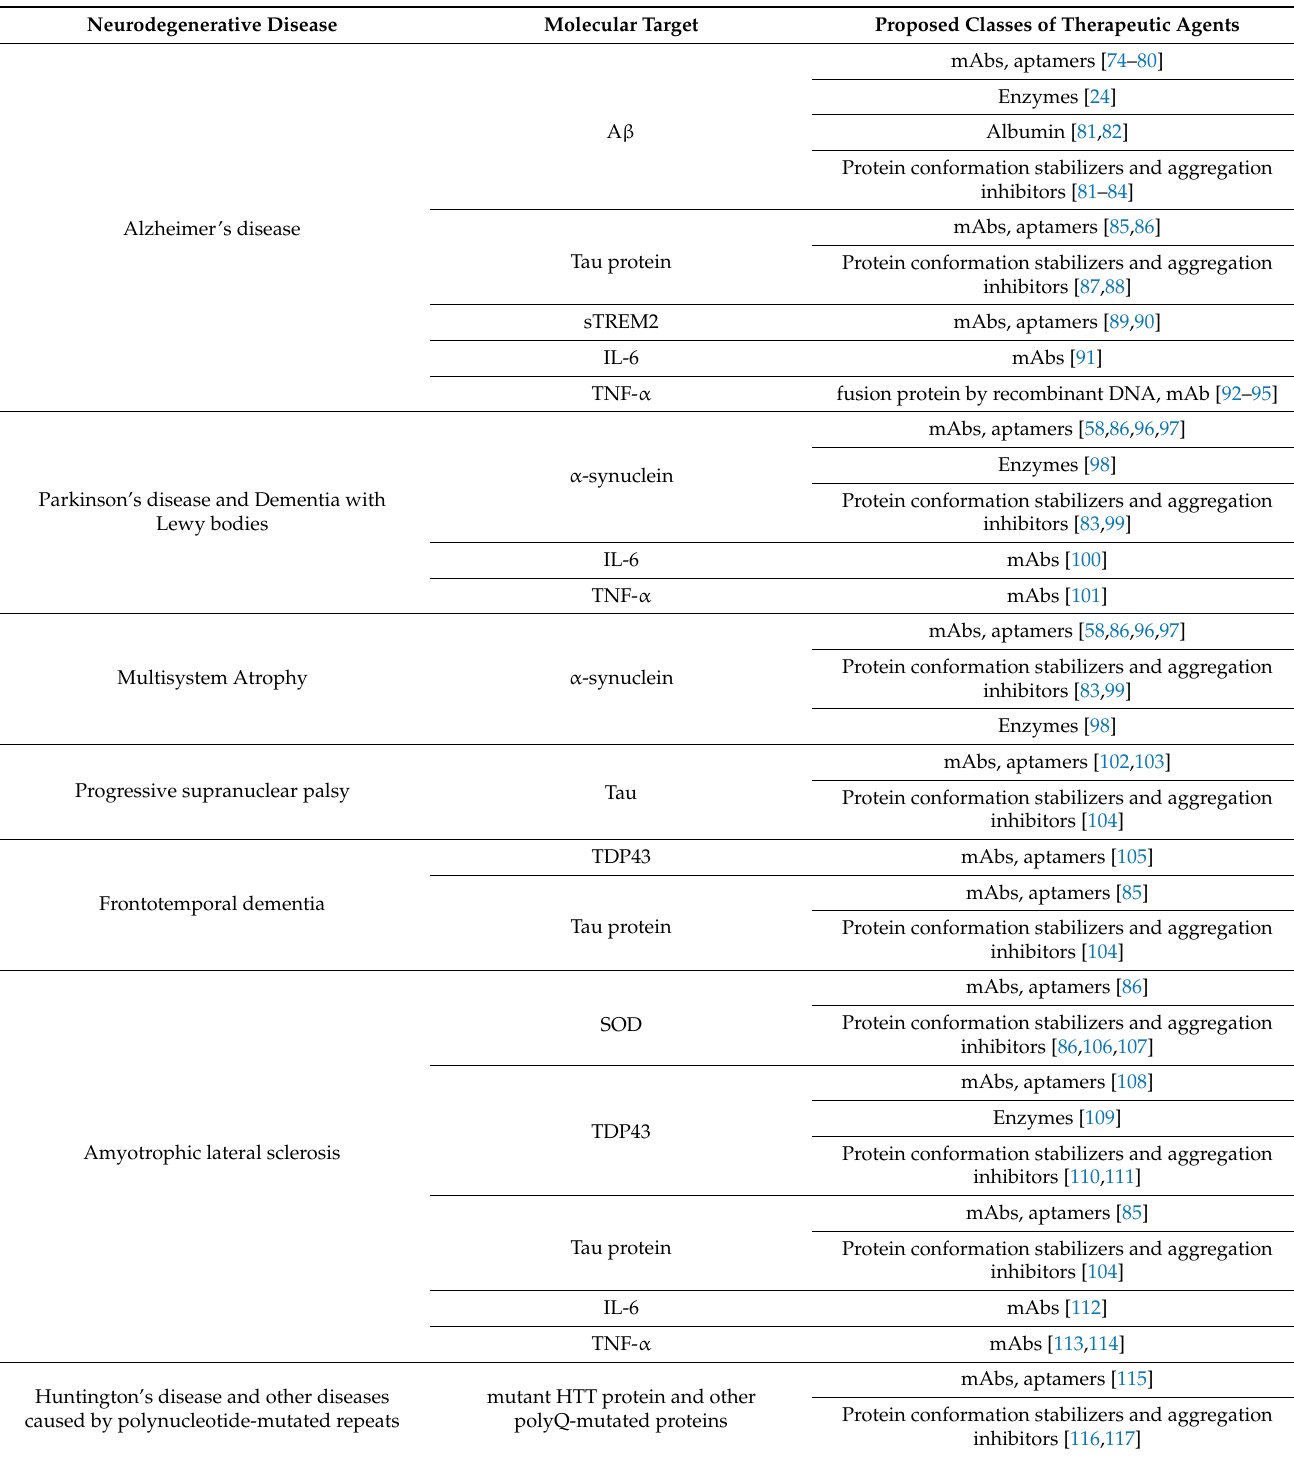
Table 1. Summary of the potential molecular targets and the proposed classes of therapeutic agents to be administered via IT pseudodelivery for the most relevant neurodegenerative